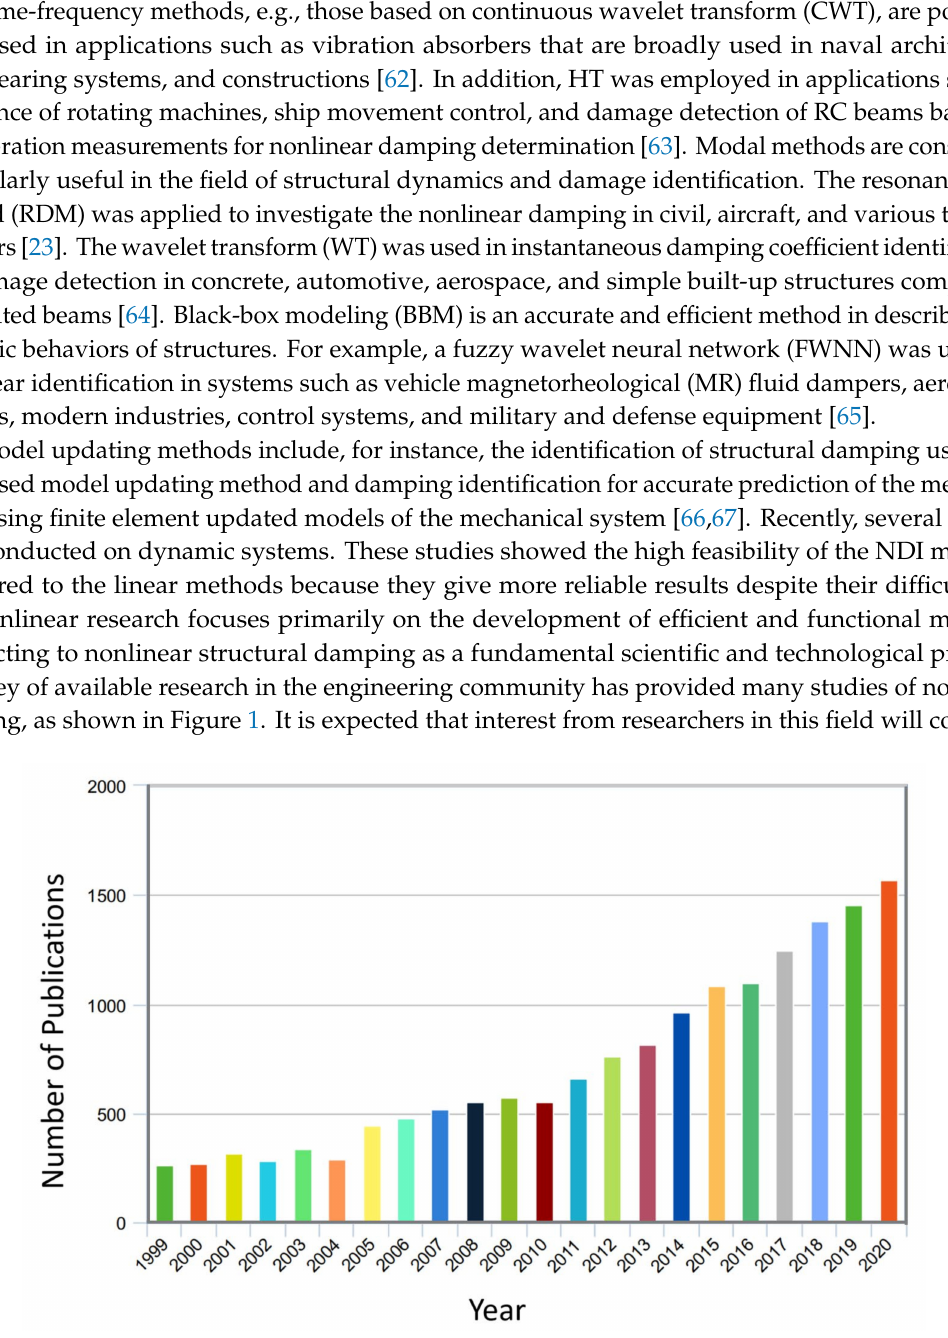
Figure 1. The number of publications for nonlinear damping studies (According to the Scopus engine system in the duration from January 1999 to November